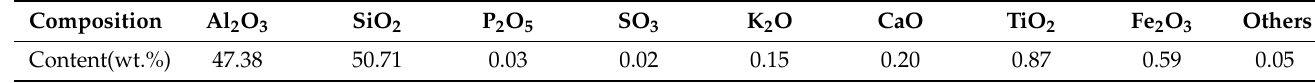
Table 1. Chemical constituent of kaolin, measured in